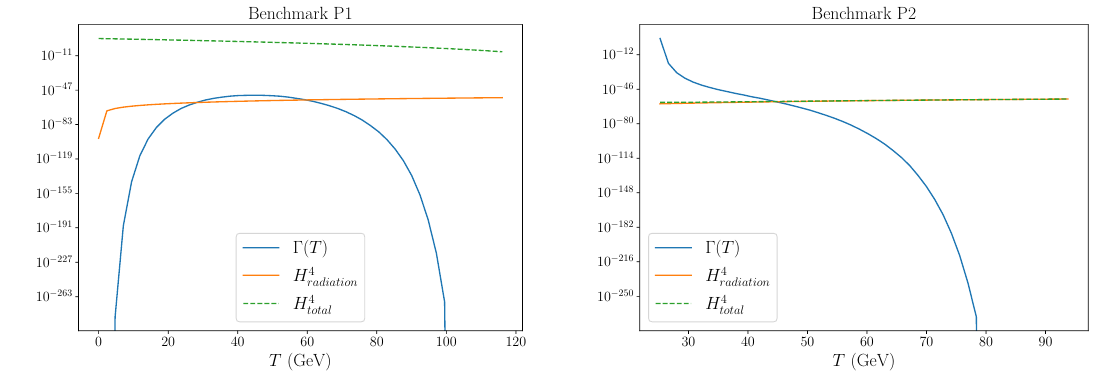
Figure 1 . Rates as functions of temperature for the two benchmarks introduced in the text. Blue curves show the finite-temperature nucleation rates, orange lines the Hubble rates including only the radiation component and green dashed lines show the total Hubble rates with the vacuum contribution